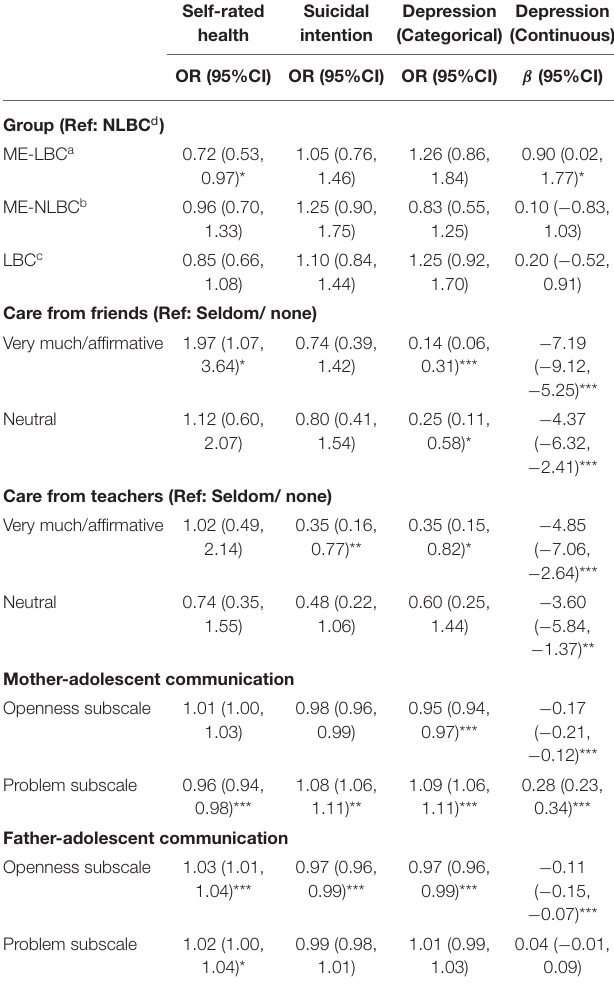
TABLE 5 | Regression coefficients for health outcomes, interpersonal relationships and groups with adjustments for social-demographic characteristics. Self-rated Suicidal Depression Depression health intention (Categorical)